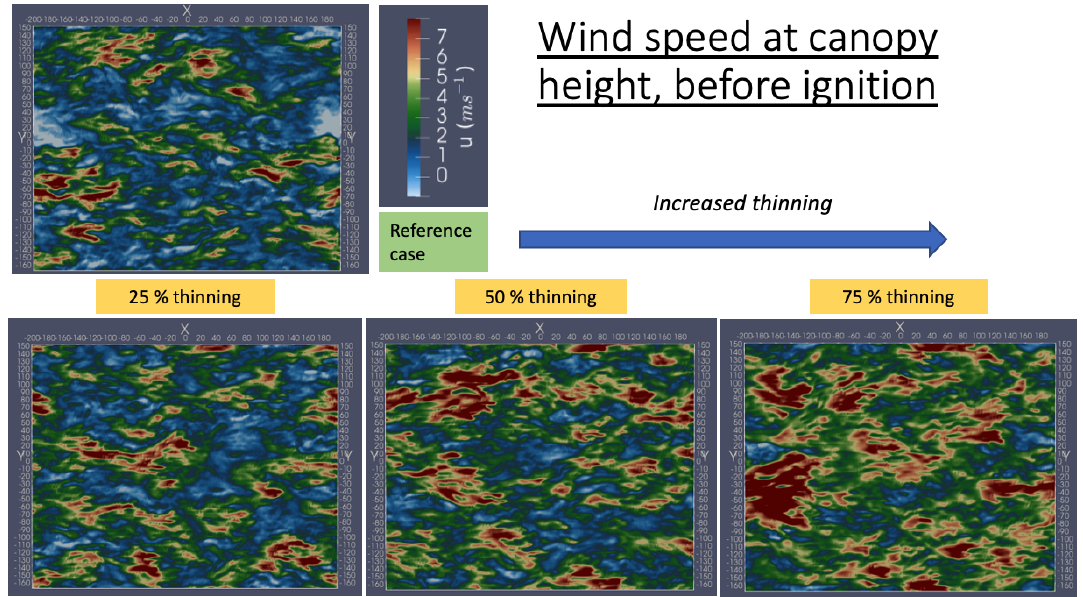
Figure 3. Wind speed at canopy height for the different simulation cases before